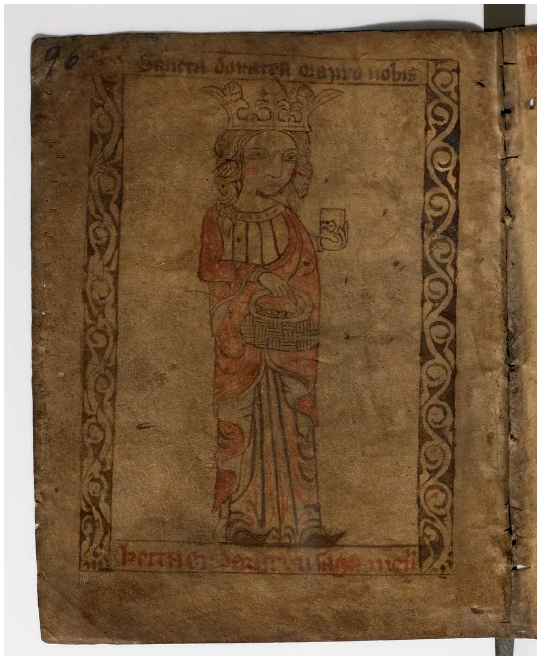
Figure 4. Image of St Dorothy, facsimile from AM 429 12mo (fol. 48v) dated between 1490–1510. Available at https://handrit.is/en/manuscript/view/en/AM12-429.